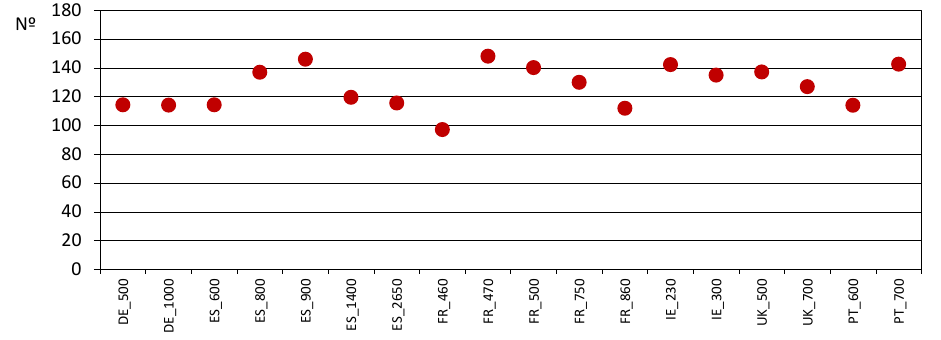
Figure 6. Weaned lambs per 100 ewes and year (n°). Source: model results.